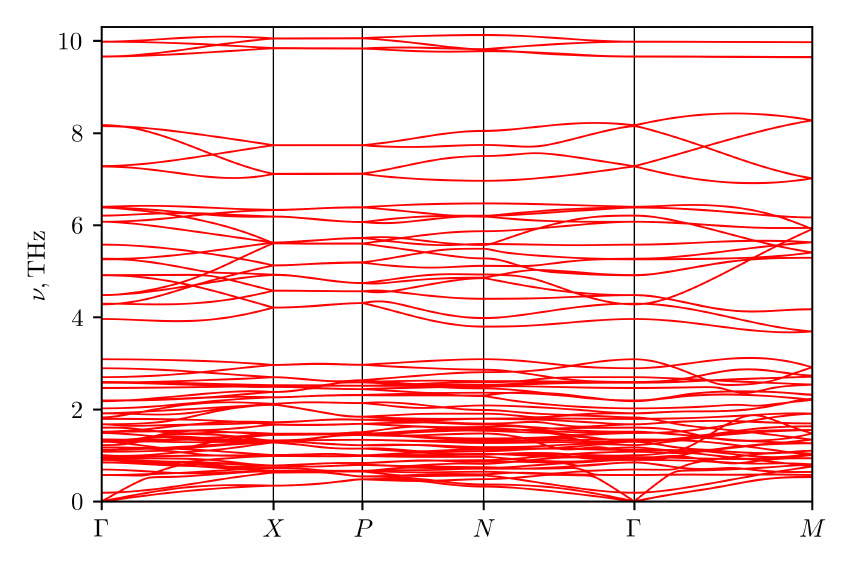
Figure 13. Phonon spectrum of Ag 3 CuS 2 (I4 1 /amd) calculated at room